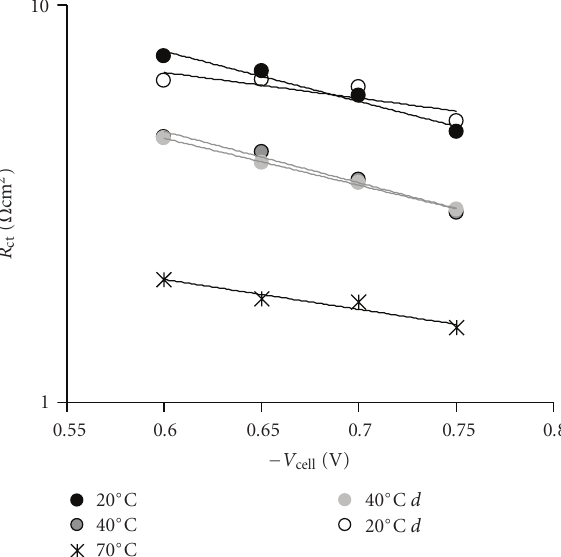
Figure 15: Charge transfer resistance on the counter electrode as a function of cell voltage; second set of EIS measurements. Letter “ d ” after the temperature value indicates the downward sweep of the temperature